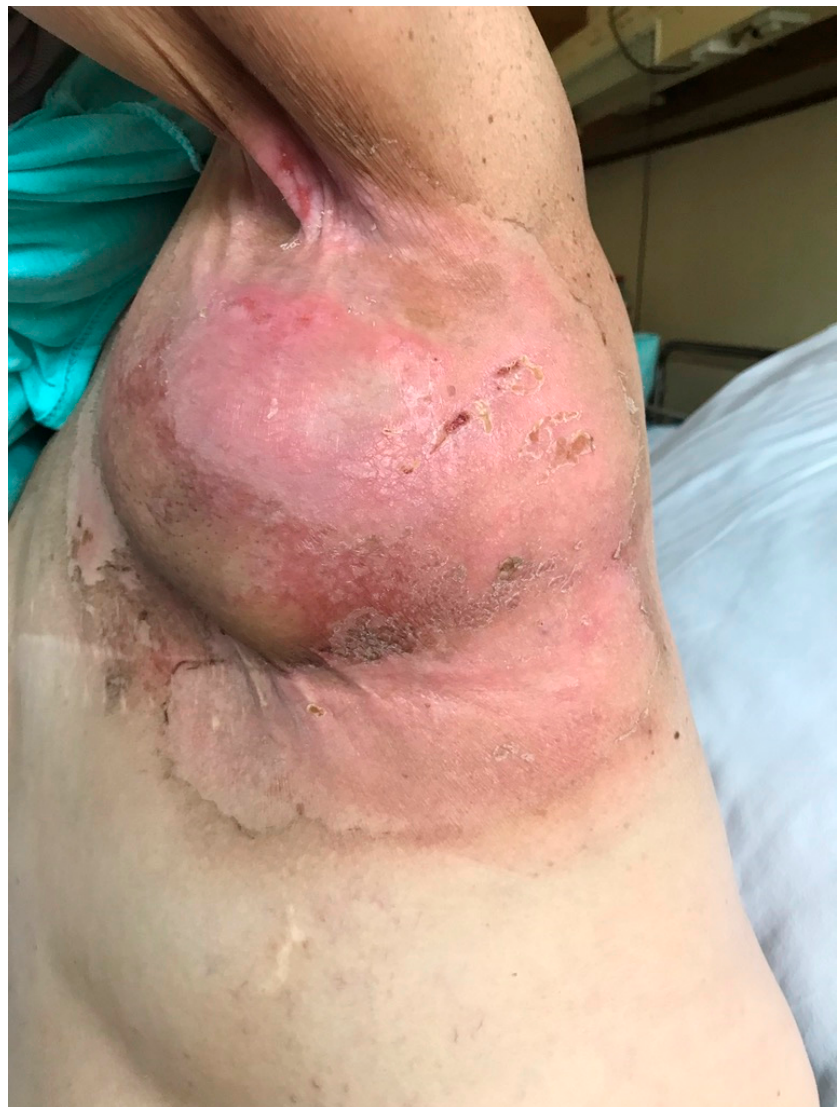
Figure 1. Grade 2 acute radiation dermatitis.